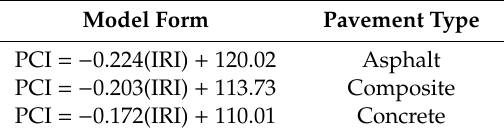
Table 2. Prediction of PCI for various pavement